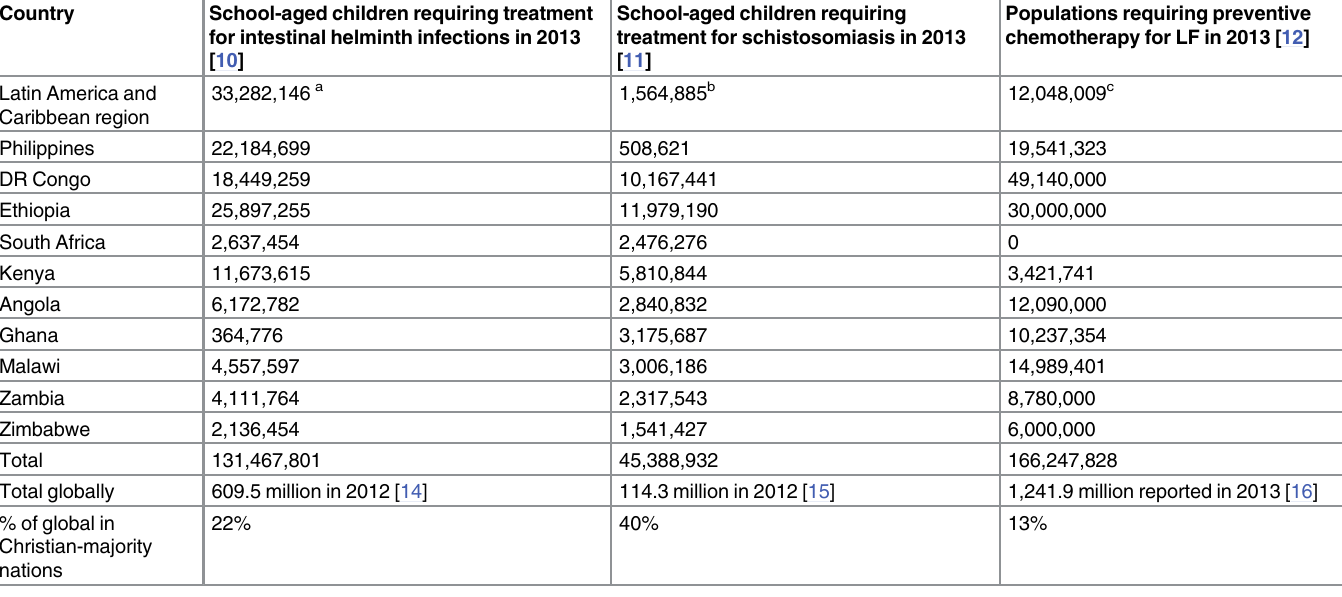
Table 1. NTDs in Christian-majority developing countries and regions.